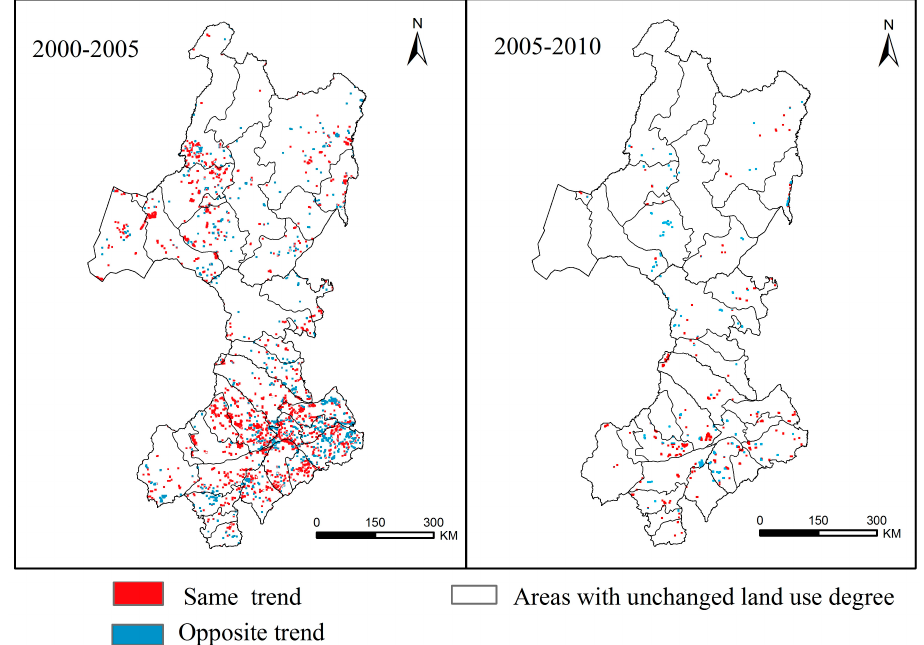
Figure 8. Change in the land use degree in different years: from 2000 to 2005 ( left ) and from 2005 to 2010 ( right ).